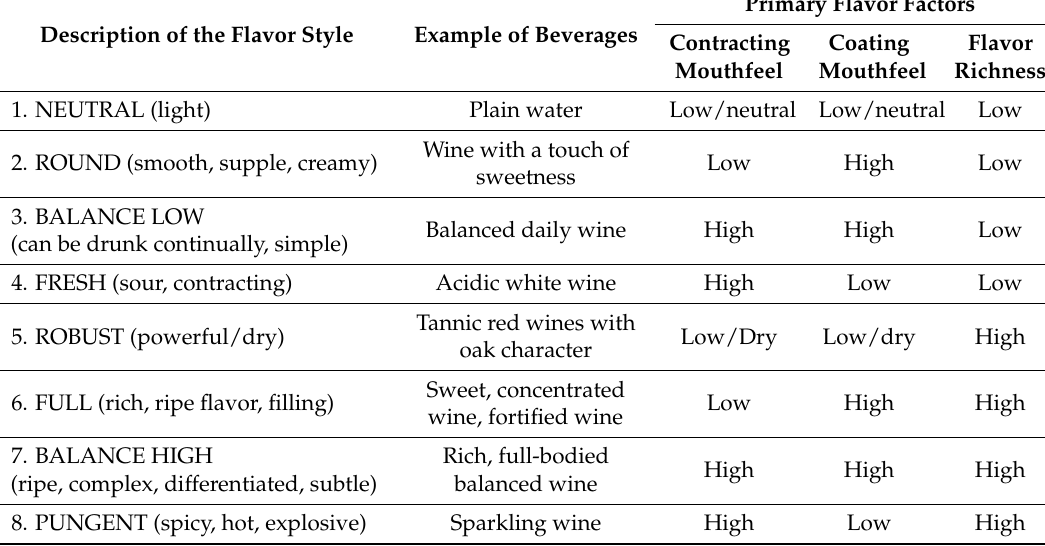
Table 1. Description of the flavor